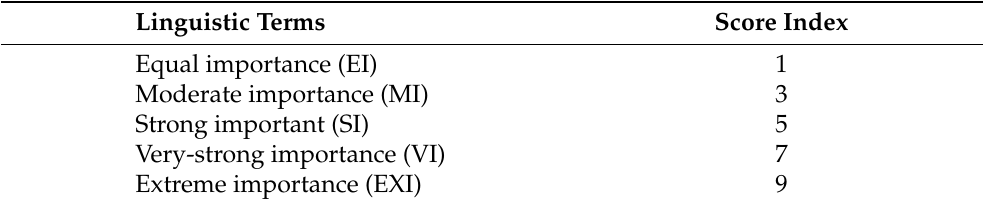
Table 7. Linguistic terms for judging